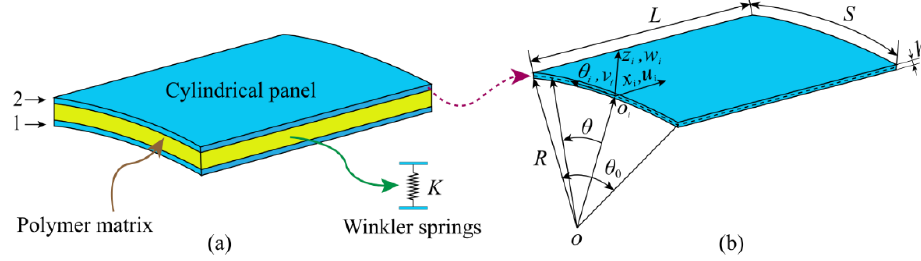
Figure 1. Schematic diagram of the GPLRP, two-cylindrical-panel system. ( a ) two-cylindrical- panel system; ( b ) single-cylindrical-panel